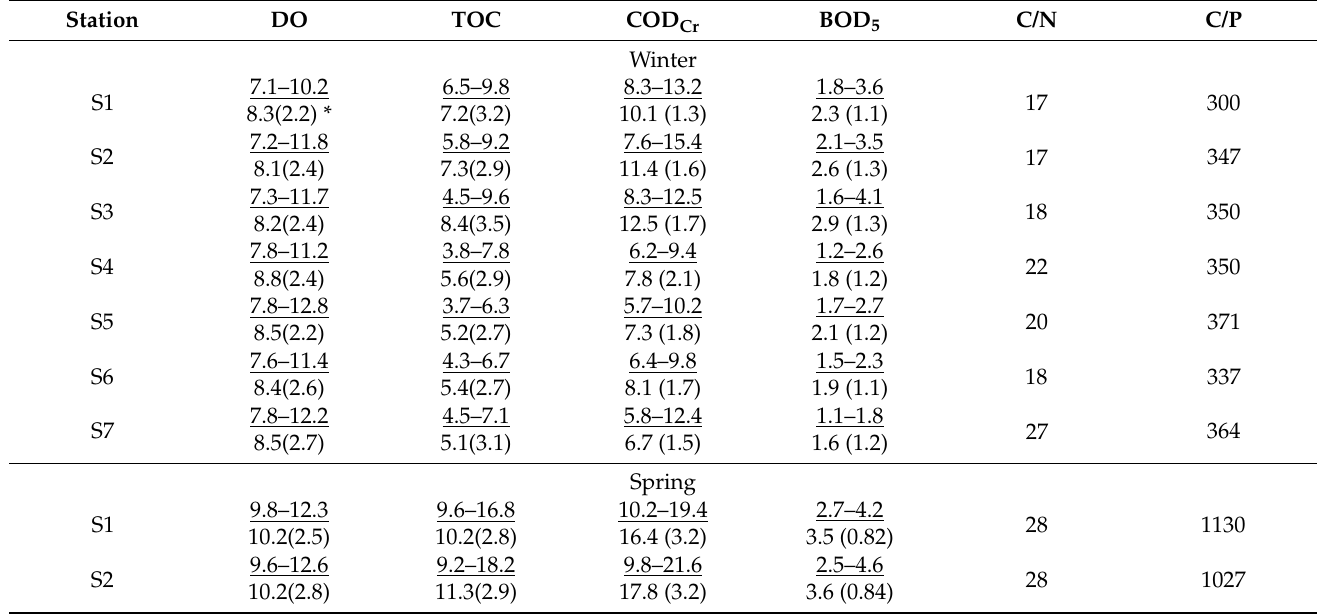
Figure 2. The distribution pattern of nutrients in Lake Gusinoe during the year. Organic matter. The organic matter (OM) concentrations varied considerably between Table 3. Nutrient distribution for Lake Gusinoe waters during 2016–2018. different samples (Table 4). The OM composition during ice-free periods depended largely on the annual precipitation and hydrometeorological conditions, which control the intensity Station of the water exchange. Given the high precipitation during the spring of 2017, there were elevated levels of dissolved oxygen, DO (11.8 mg · L − 1 ), chemical oxygen demand, COD (21.8 mg · L − 1 ), and total organic carbon, TOC (16.2 mg · L − 1 ), content. The concentrations of the chemical oxygen demand (COD) and biological oxygen demand (BOD 5 ) were much higher in the summer, at 36,5 and 5.3 mg · L − 1 , respectively, compared to those measured in the winter. At the same time, for example, the concentration of dissolved oxygen (DO) exhibited a decrease in the highest concentrations from 10.8–11.8 to 9.3–9.8 mg · L − 1 at sites S1–S3. The results of the statistics multiple regression are displayed in Figure 3. The distribution pattern indicates that organic matter (OM) concentrations were at the highest values at sites S1–S3. Table 4. Dissolved oxygen, total organic carbon, and chemical and biological oxygen, including the elemental composition of the water samples from Lake Gusinoe in 2016–2018, measured in mg · L − 1 .